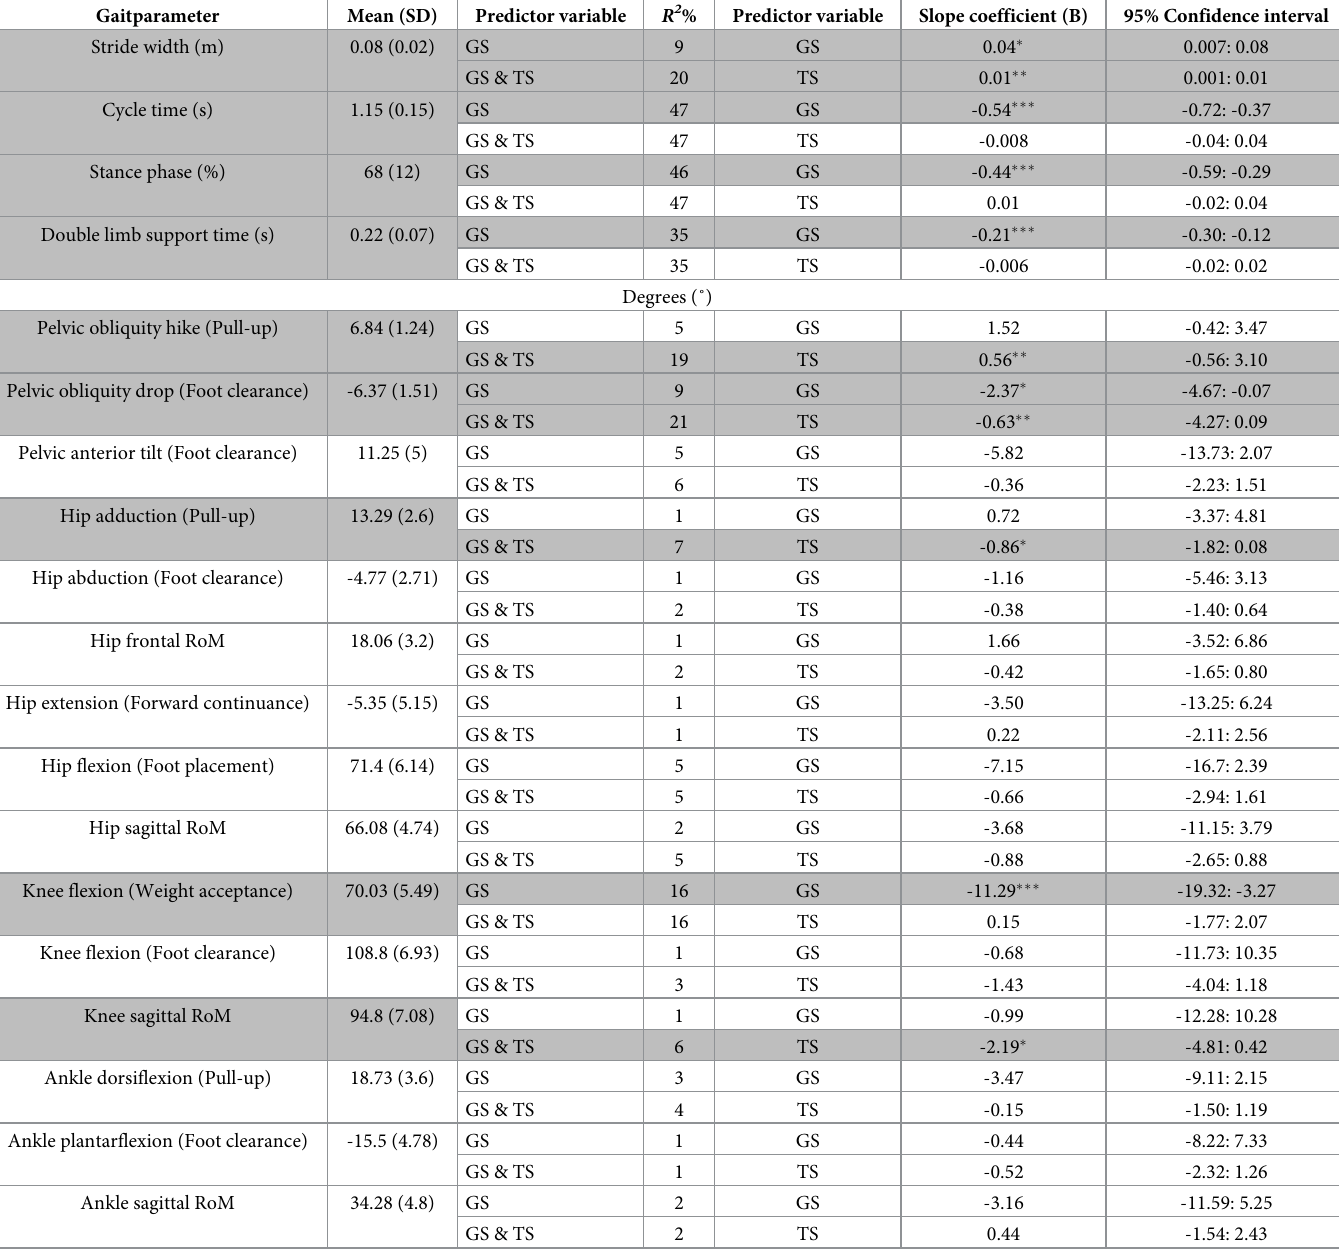
Table 2. Explained variance ( R 2 ) and slope coefficient for temporal-spatial and joint kinematics during stair ascent.